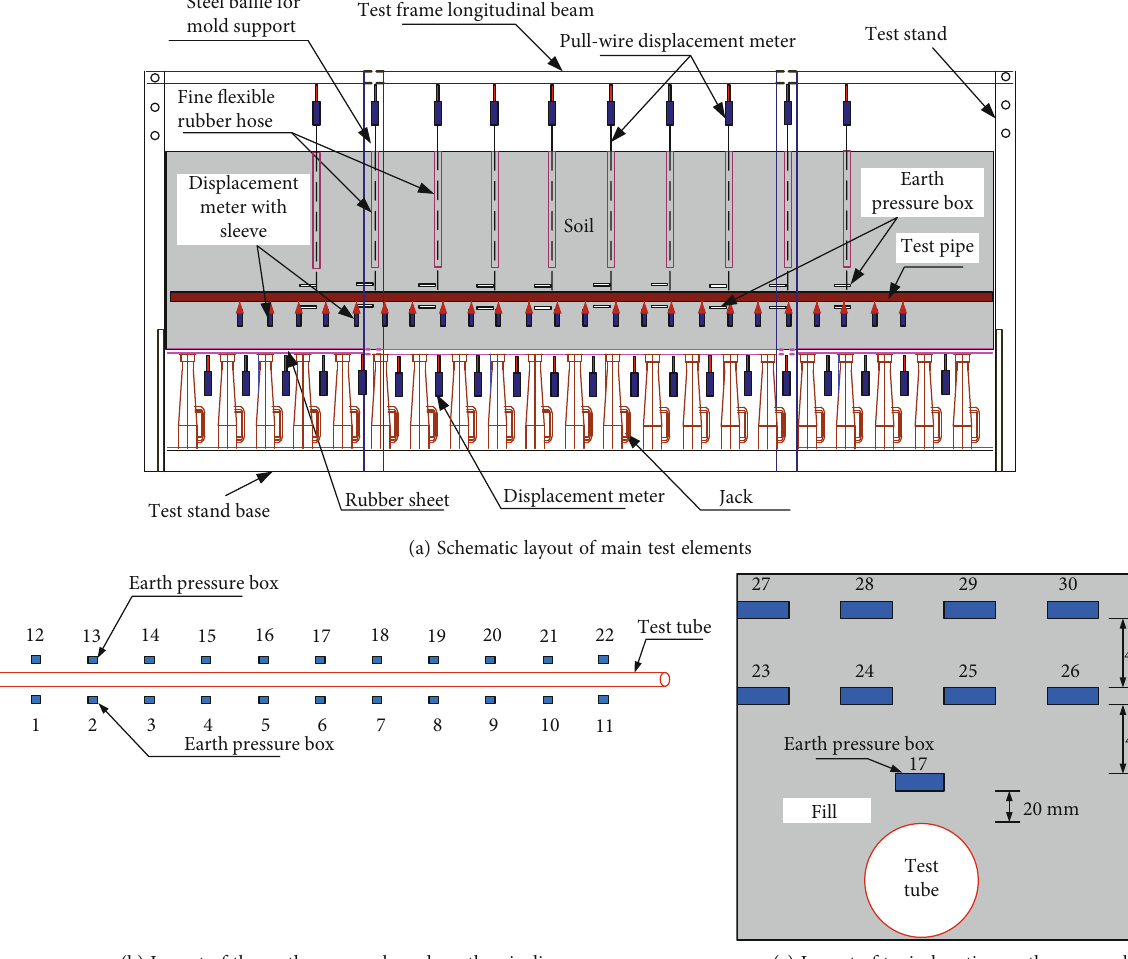
Figure 1: Arrangement of the main test